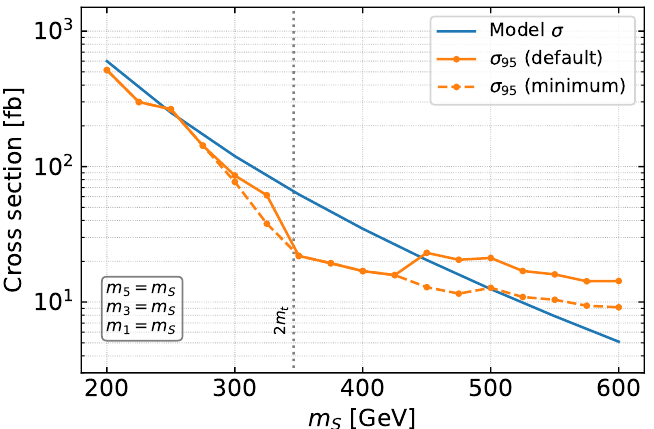
Figure 12. Bounds on the pNGB masses for the Drell-Yan production of the full bitriplet with decays to third-generation